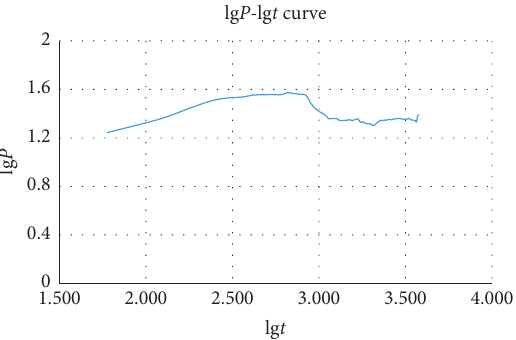
Figure 9: The lgP-lgt curve of some CBM well.